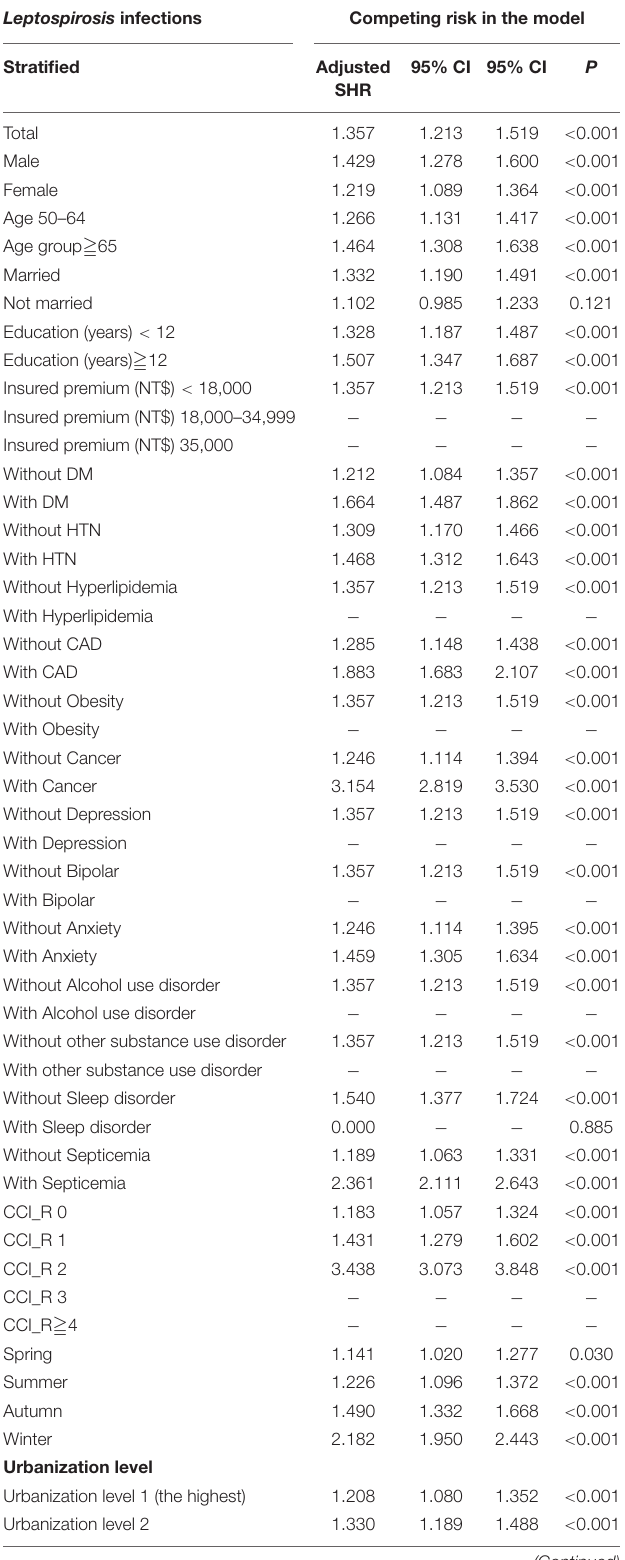
TABLE 4 | Subgroup analysis stratified by variables listed in the table by using Fine and Gray’s competing risk model. Leptospirosis infections Competing risk in the